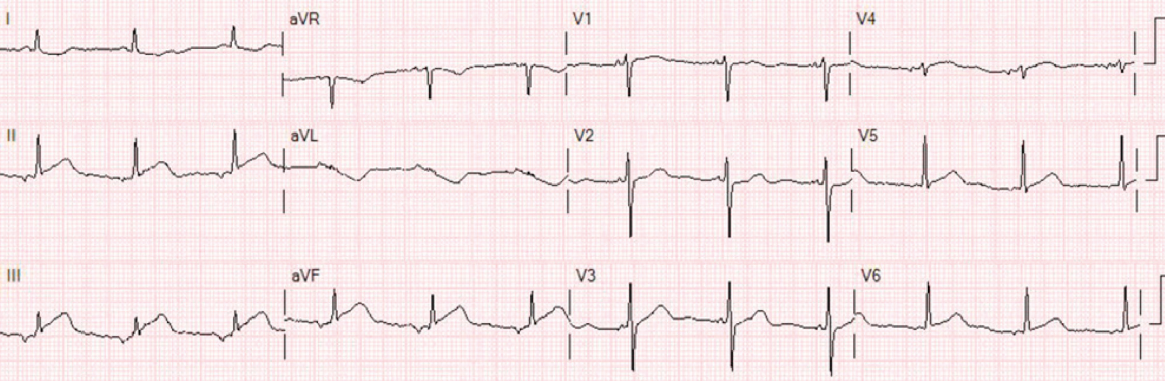
Figure 1: EKG showing ST elevation at II, III, and aVF with reciprocal ST depression at I and aVL.